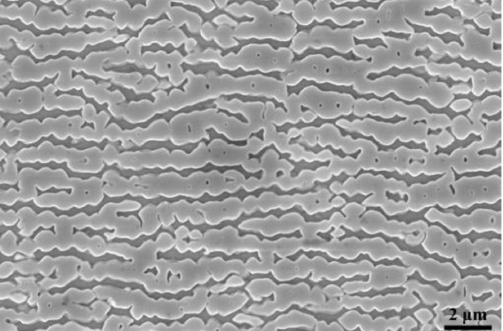
Figure 4. SEM-SE images of the γ ’ precipitates in the dendrite cores away from the fracture along the longitudinal sections for the specimens under 980 ◦ C/275 MPa after being exposed to 880 ◦ C/70 MPa for 500